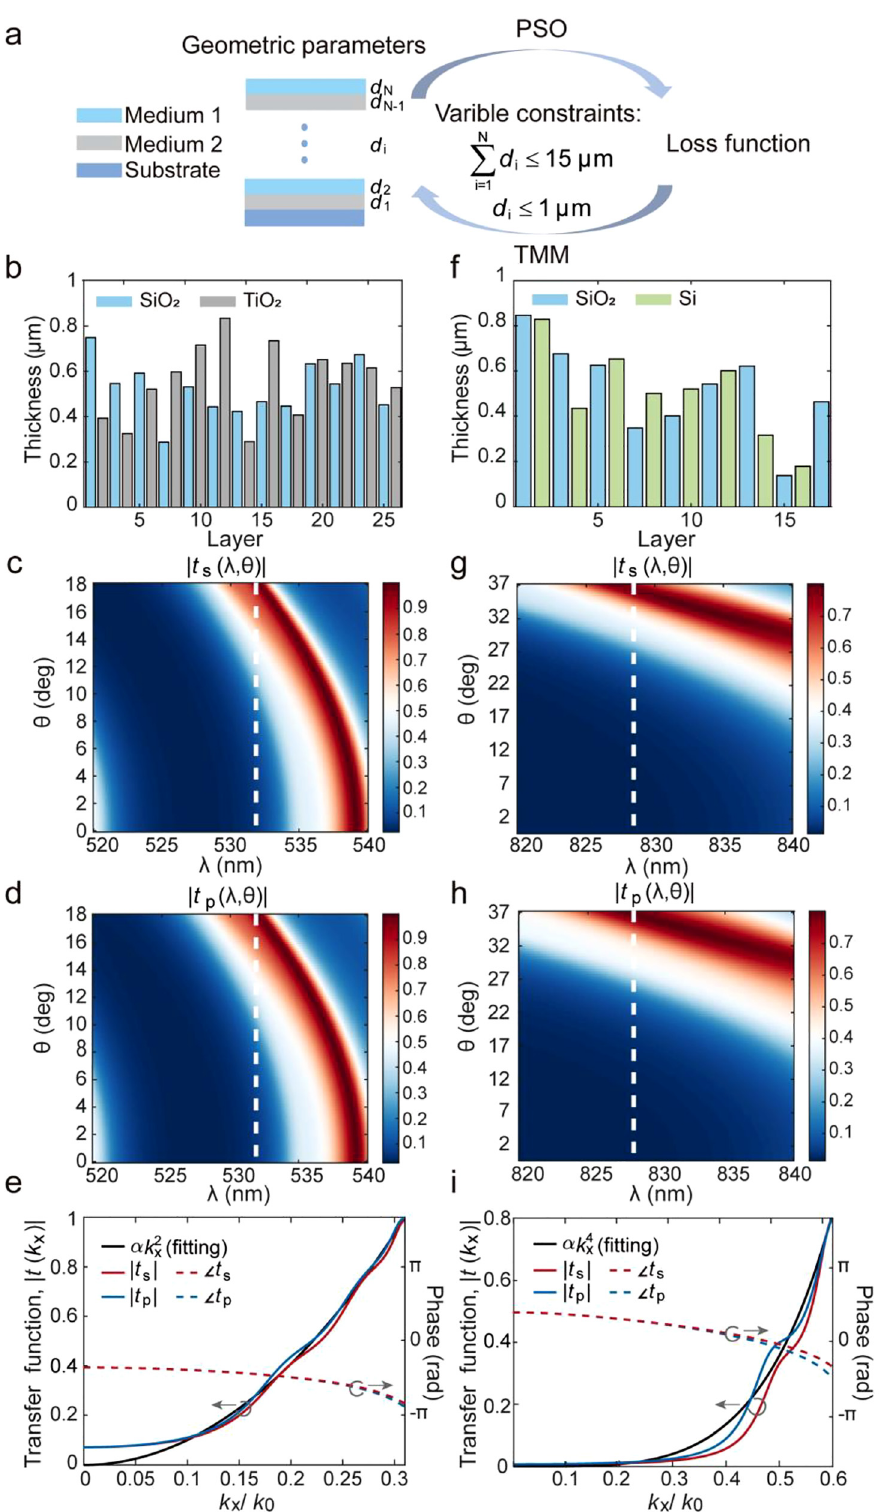
Figure 2: (a) Optimization flow of the multilayer thin film geometric parameters, which stack consisting of two materials with large refractive index contrast supported on a transparent substrate, with the parameter constraints imposed by the stress in a thick dielectric film stack. (b) Optimized thickness distribution of the multilayer film consisting of alternating layers of SiO 2 and TiO 2 . (c) and (d) calculated transmission amplitudeasafunctionofwavelengthandincidentangleoftheSiO 2 /TiO 2 designfor s -(c)and p